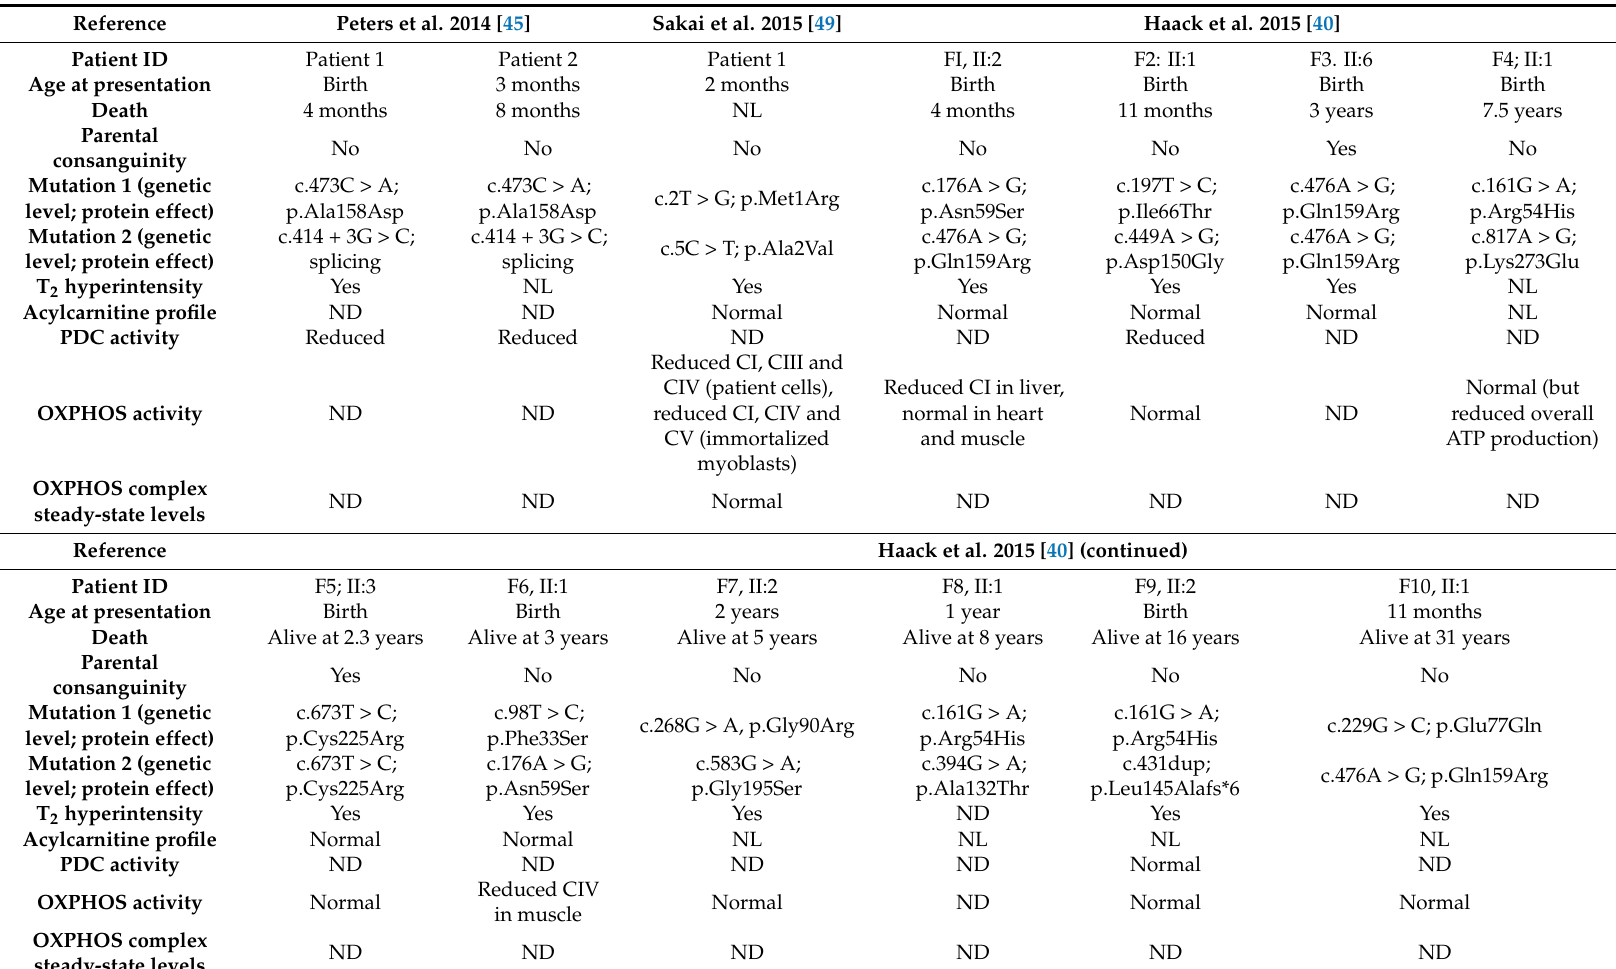
Table 1. The clinical, biochemical and metabolic features of all reported ECHS1D